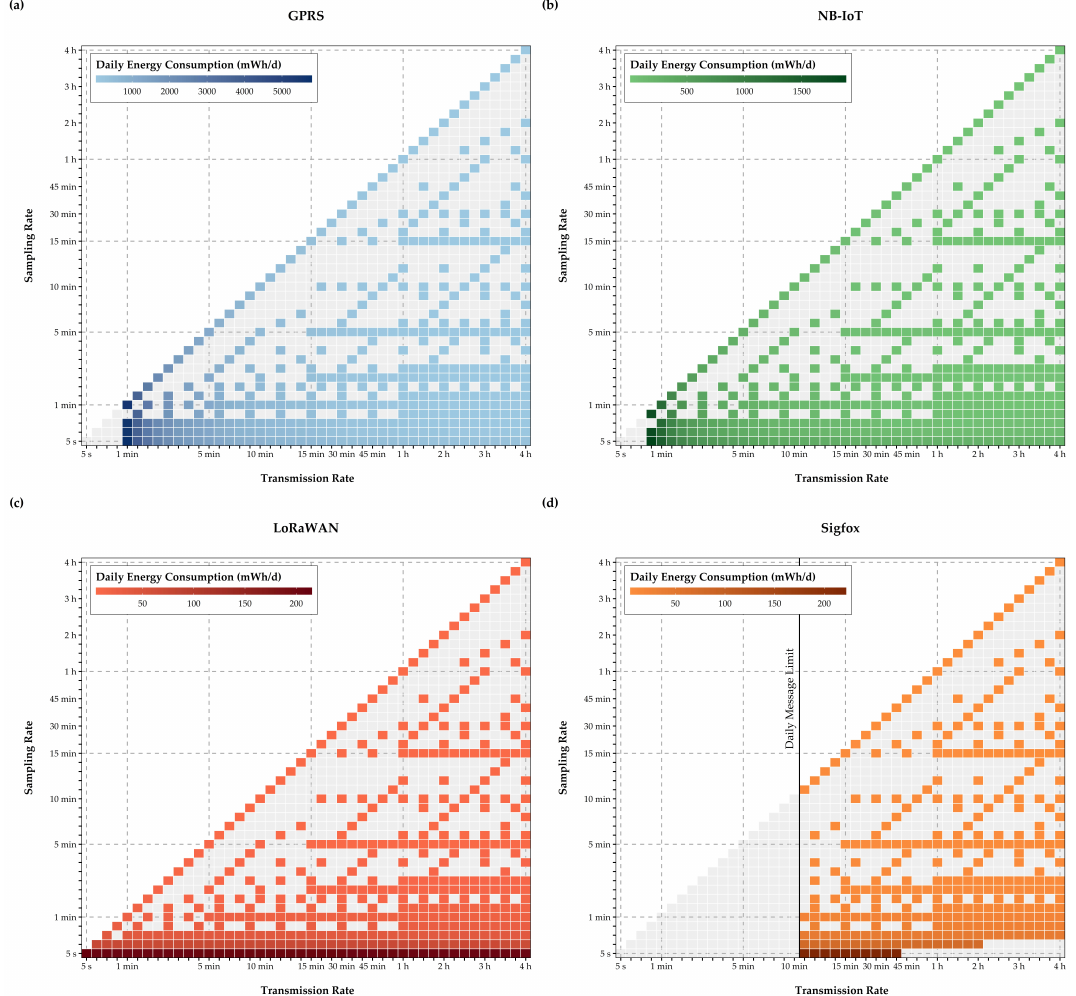
Figure 8. Daily energy consumption for feasible EPMD configurations ( a – d